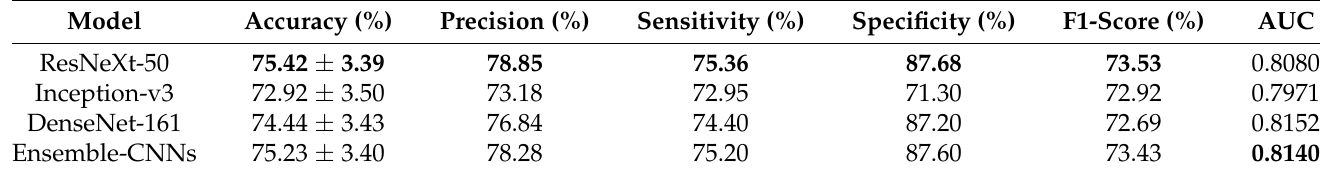
Table 8. The experimental results for the testing data of our proposed three-class COVID-19 database. Model